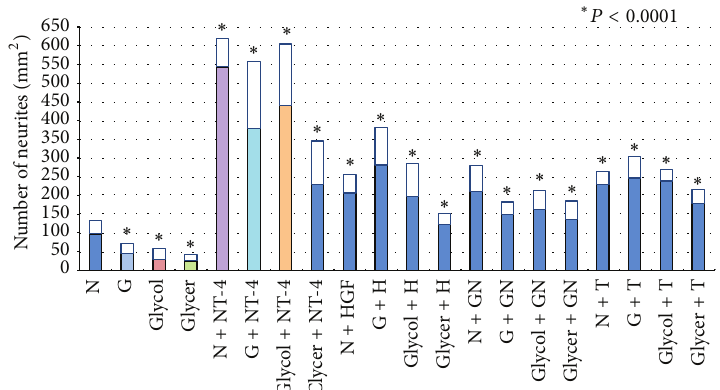
Figure 7: Graph showing the number of regenerating neurites in all groups. N, serum-free media, G, glucose-AGE-BSA; Glycol, glycolaldehyde-AGE-BSA; Glycer, glyceraldehyde-AGE-BSA; NT-4, neurotrohin-4; H, hepatocyte growth factor; GN, glial cell line-derived neurotrophic factor; T, tauroursodeoxycholic